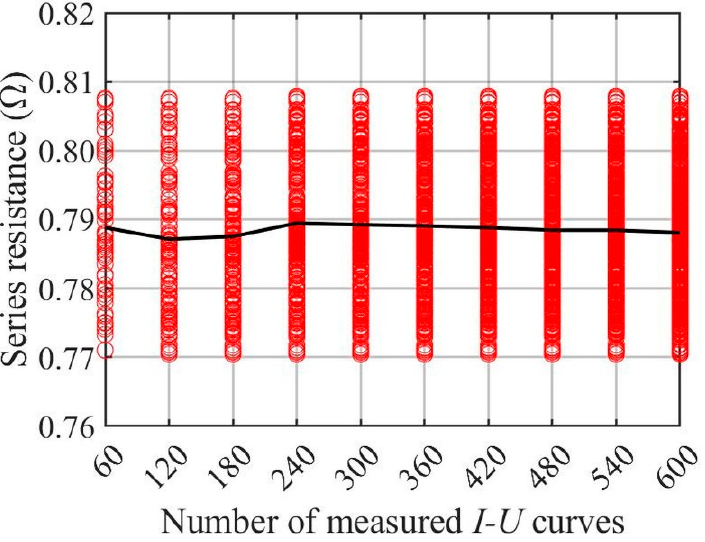
Figure 18. Fitted series resistance values (fitted to the entire I – U curves with 100 representative points) and their mean value as a function of the measurement period length starting from the curve at 1201 s.